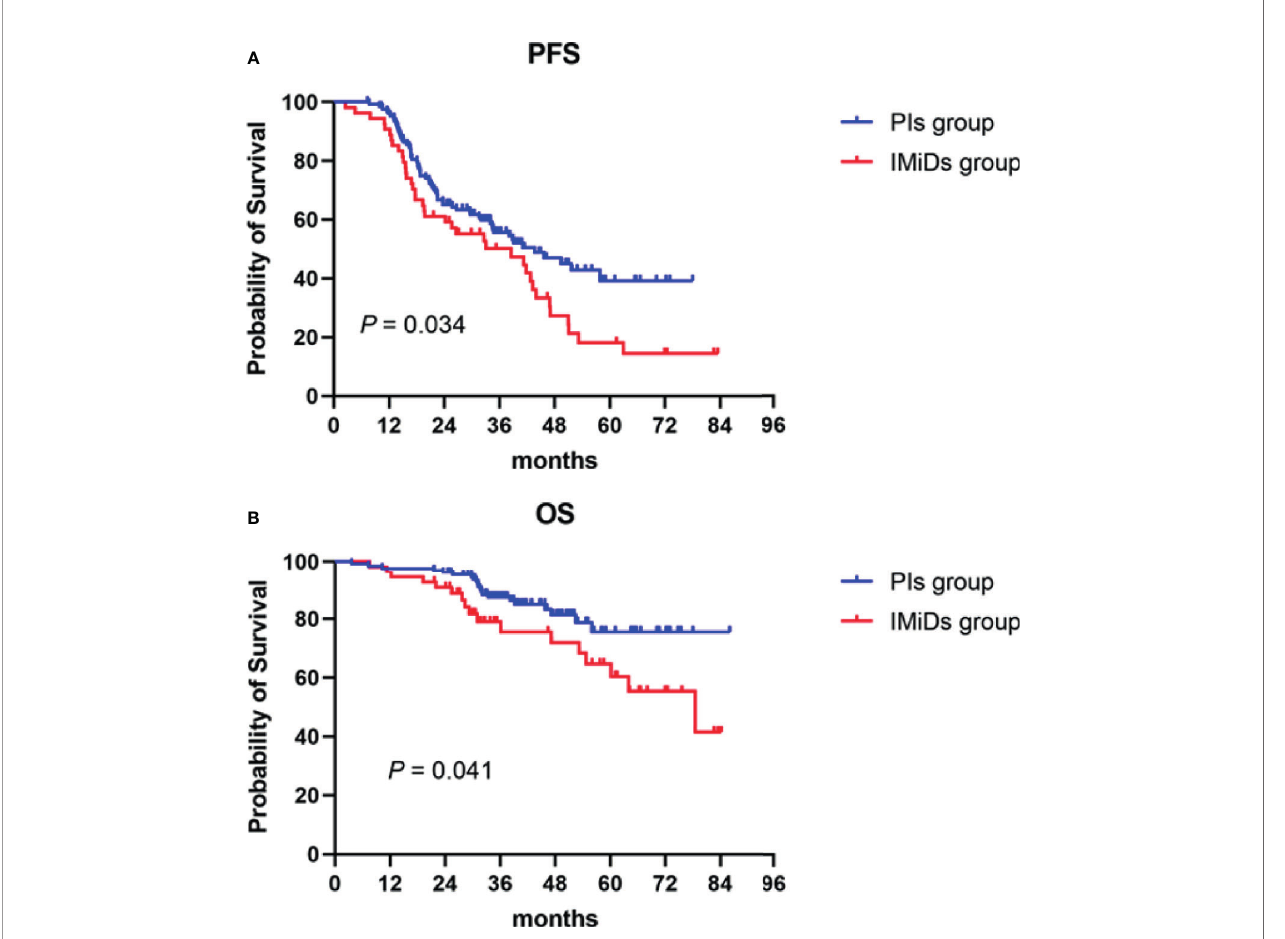
FIGURE 2 | Progression-free (PFS) and overall survival (OS) in NDMM patients who received PIs or IMiDs maintenance therapy. Kaplan – Meier curves are shown for (A) PFS and (B) OS. PIs, proteasome inhibitors; IMiDs,